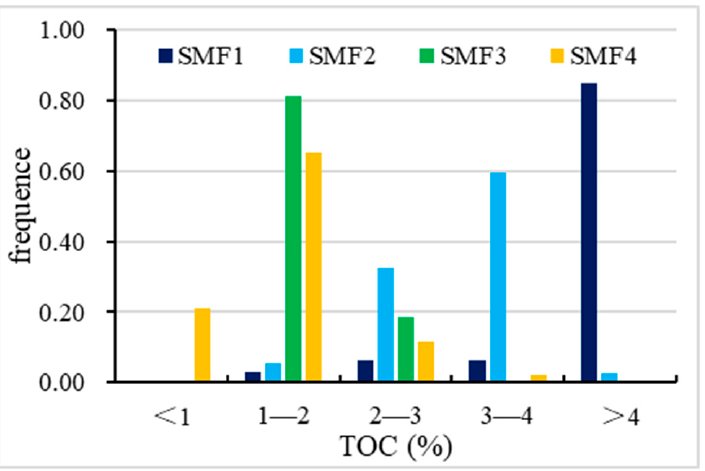
Figure 6. Distribution of total organic carbon (TOC) in different sedimentary microfacies of Wufeng-Longmaxi Formation in Well A. SMF: sedimentary microfacies.